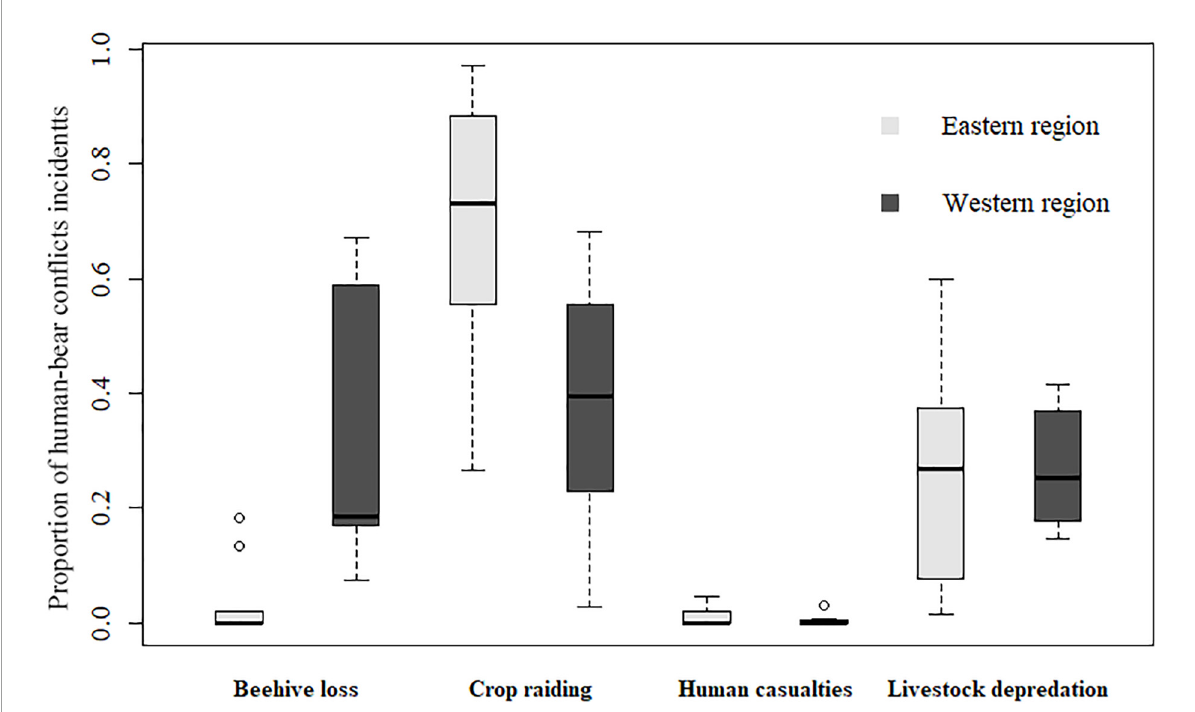
FIGURE3 Proportion of different types of human-bear conflicts in the western and eastern region around Baoshan Section of Gaoligongshan Nature Reserve during 2012–2020.